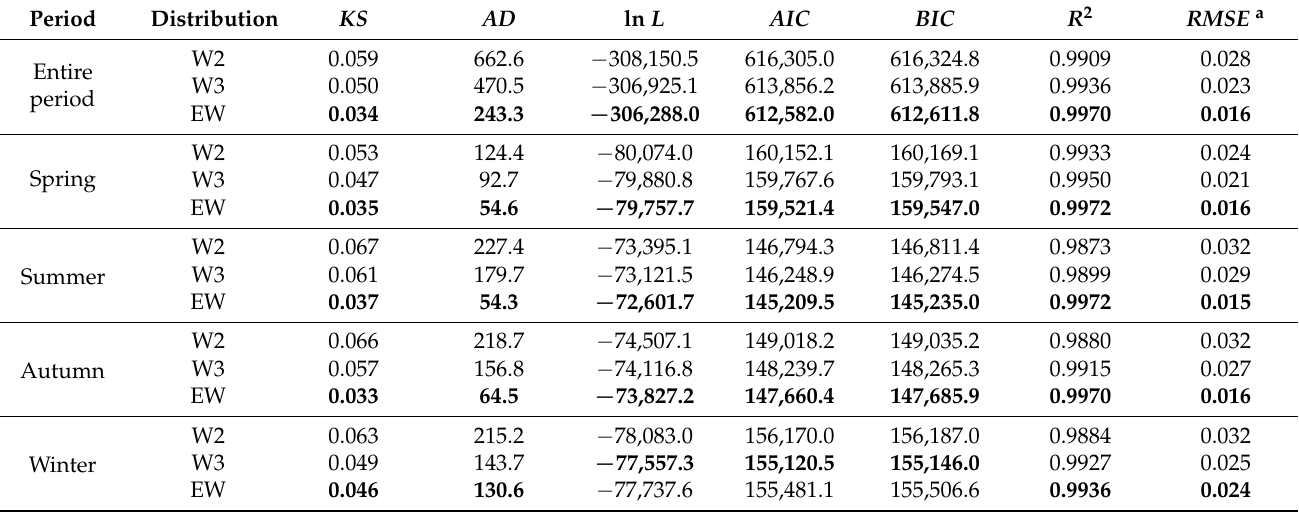
Table 6. The GOF tests and model selection criteria for the entire considered period and for the seasons.